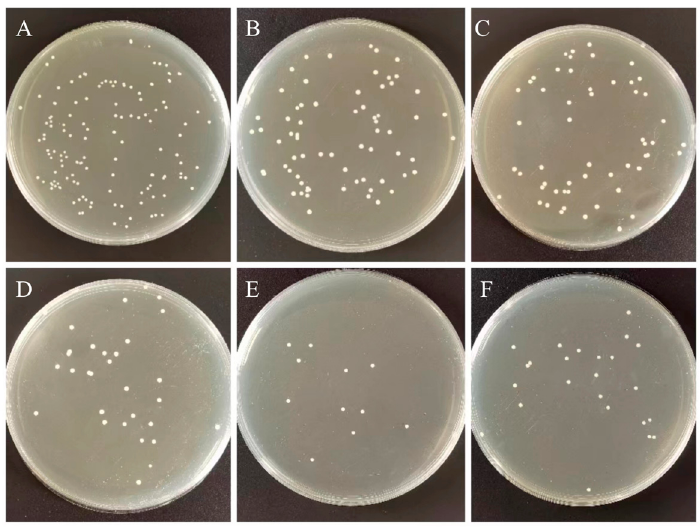
Figure 6. Diagram schematic of plate count method. ( A – F ) indicate hAP (0 wt%, 0.2 wt%, 0.6 wt%, 1.0 wt%, 1.4 wt%, and 1.8 wt%).